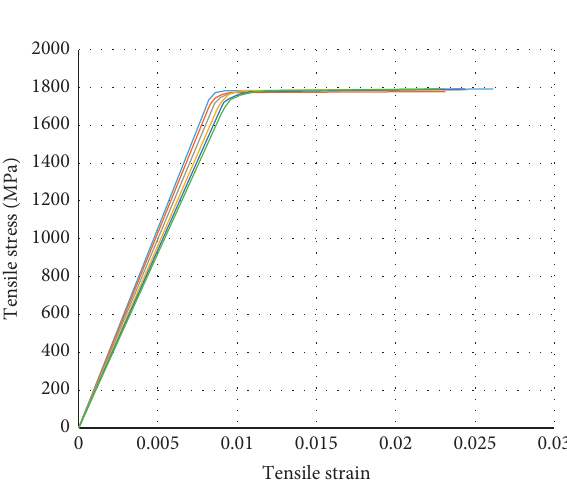
Figure 1: Examples of stress-strain curves of wires in Corrosion Stage